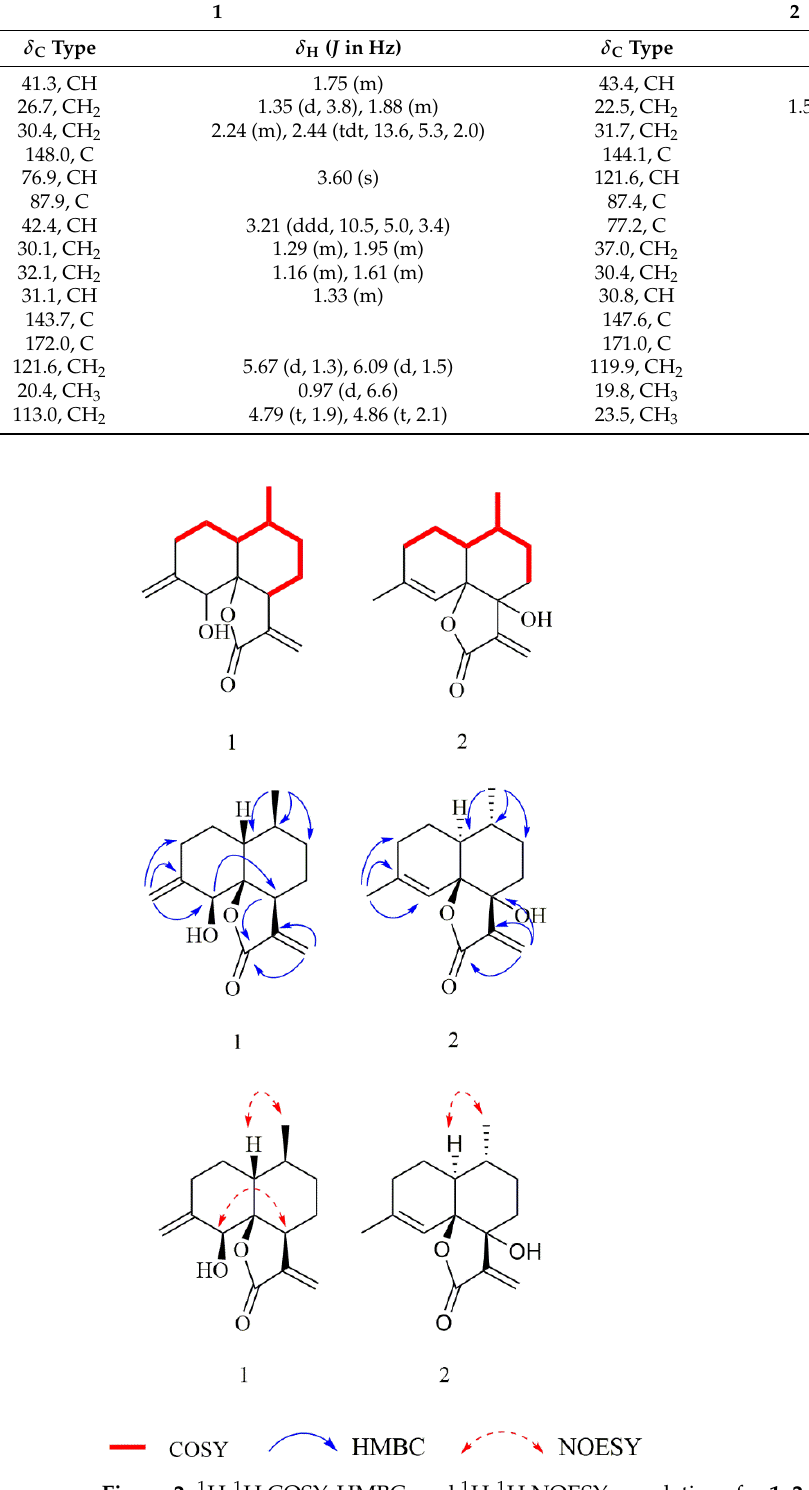
Figure 3. Results of DP4+ analysis for 1 and 2 .